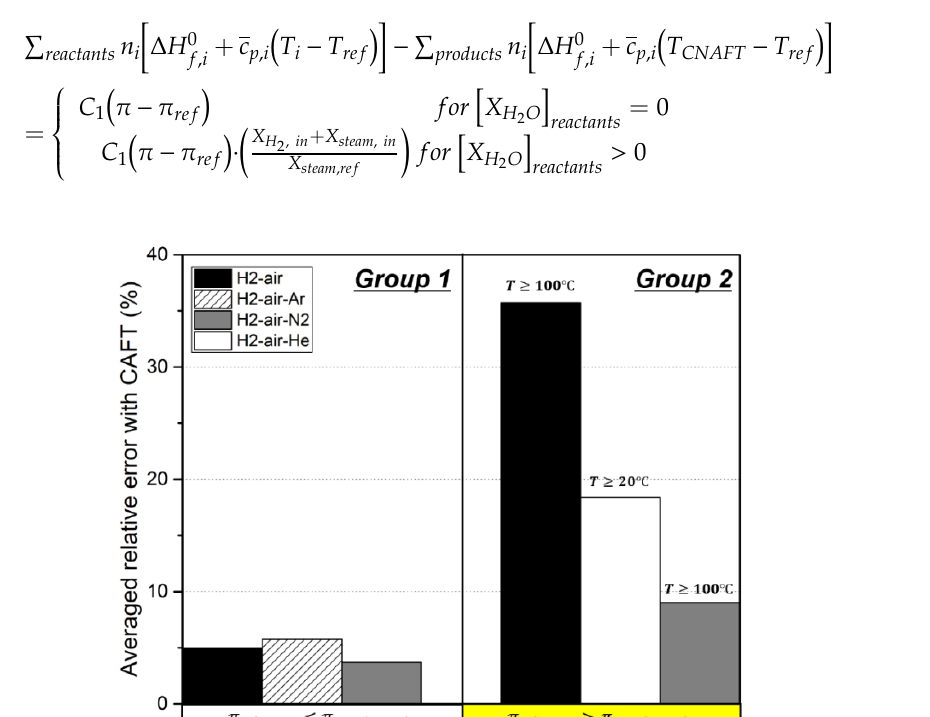
Figure 20. Classification of mixtures according to CNAFT coefficient to confirm the deterministic effects on heat loss mechanism, Reproduced from Ref. [11], Korean Nuclear Society: 2019.